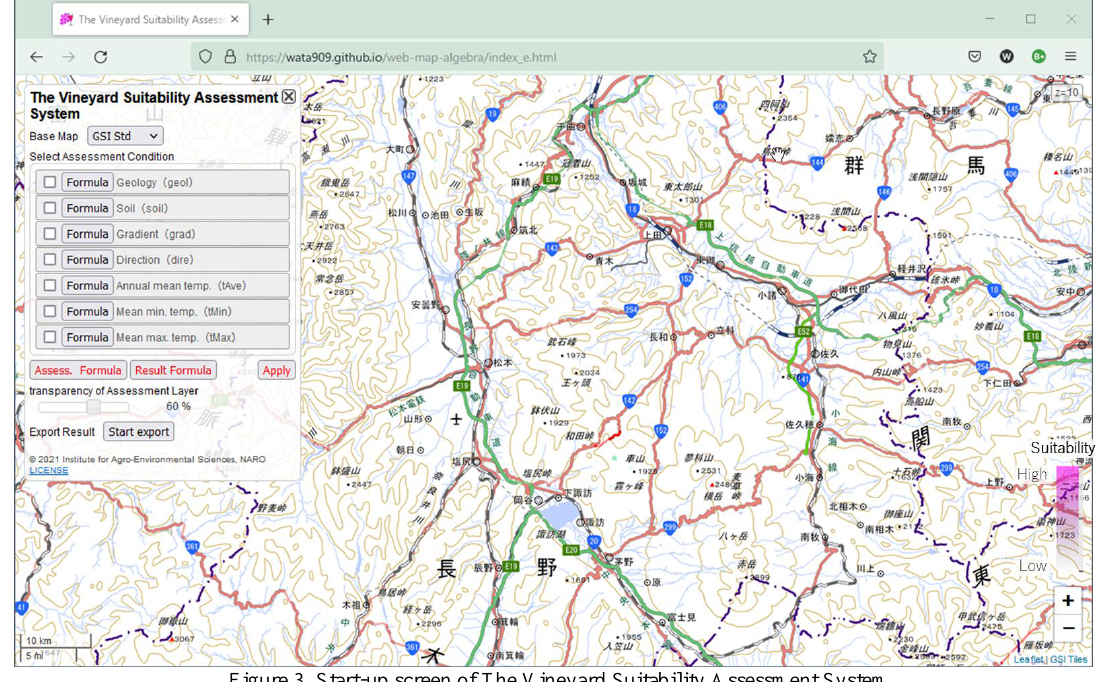
Figure 3. Start-up screen of The Vineyard Suitability Assessment System